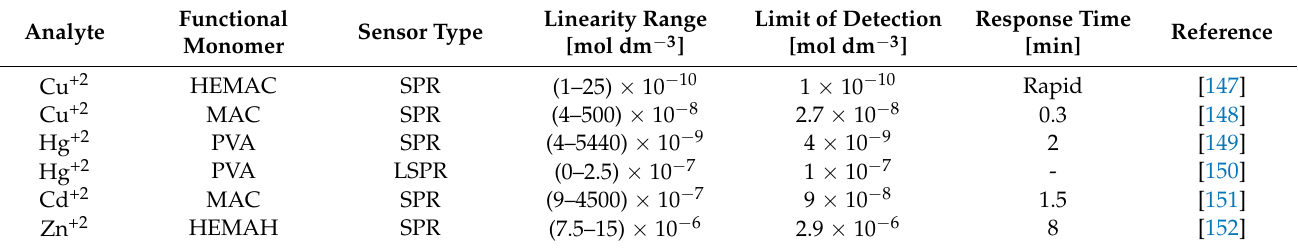
Table 4. Ion-impregnated plasmonic sensor for detection of